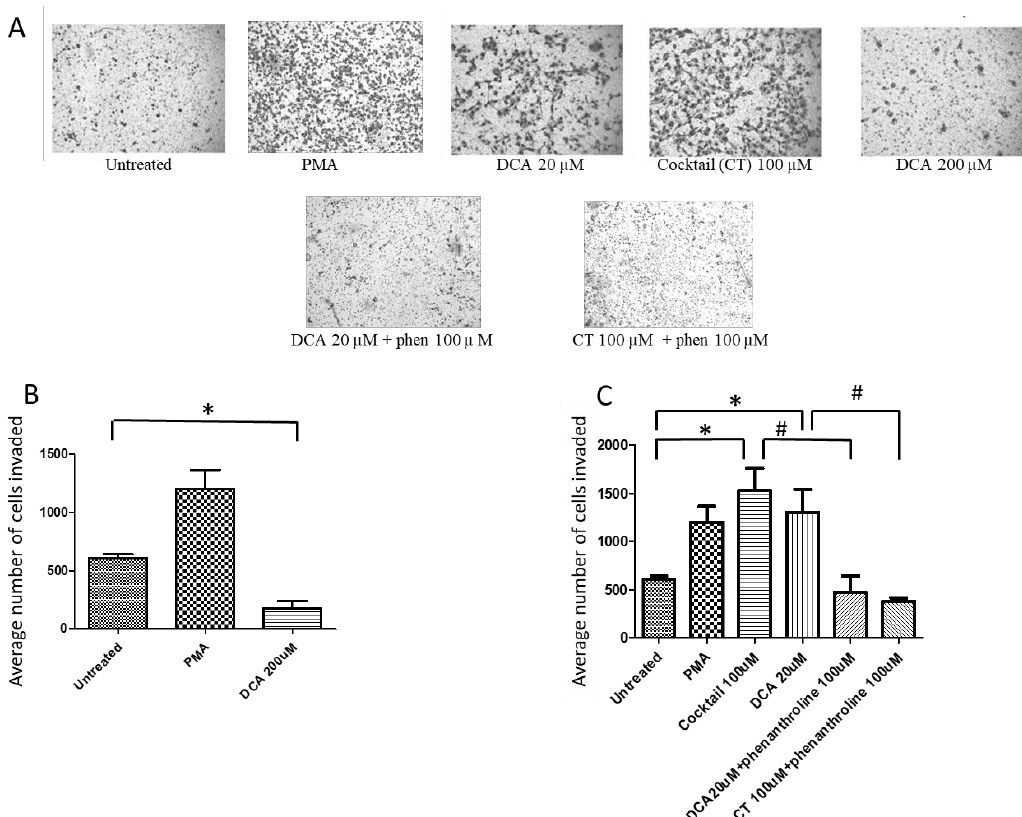
Figure 1. Effect of bile acids (Bas) on cell invasiveness. ( A ) Representative images of invasion assays in untreated SKG-4 cells and treated cells (PMA 100 µM, deoxycholic acid (DCA) 20 µM, cocktail (CT) 100 µM, DCA 200 µM, DCA 20 µM + phenantroline (phen) 100 µM and CT 100 µM + phen 100 µM). ( B ) and ( C ) The corresponding bar graph showing the results of invading cells (* p < 0.05 versus untreated cells; # p < 0.05 versus cocktail (CT) 100 μM and DCA 20 μM). n = 3 for each group .